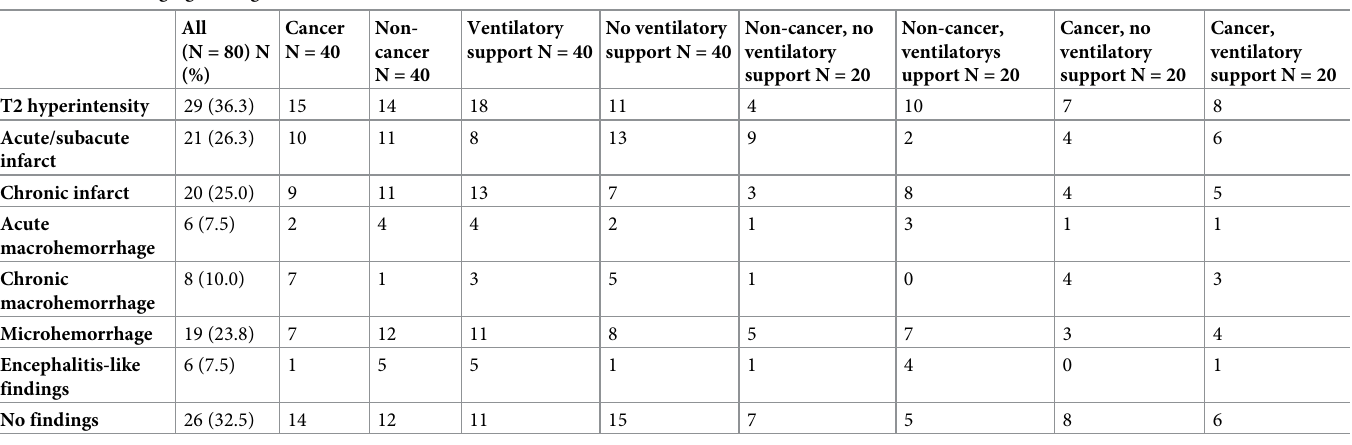
Table 2. Neuroimaging findings.